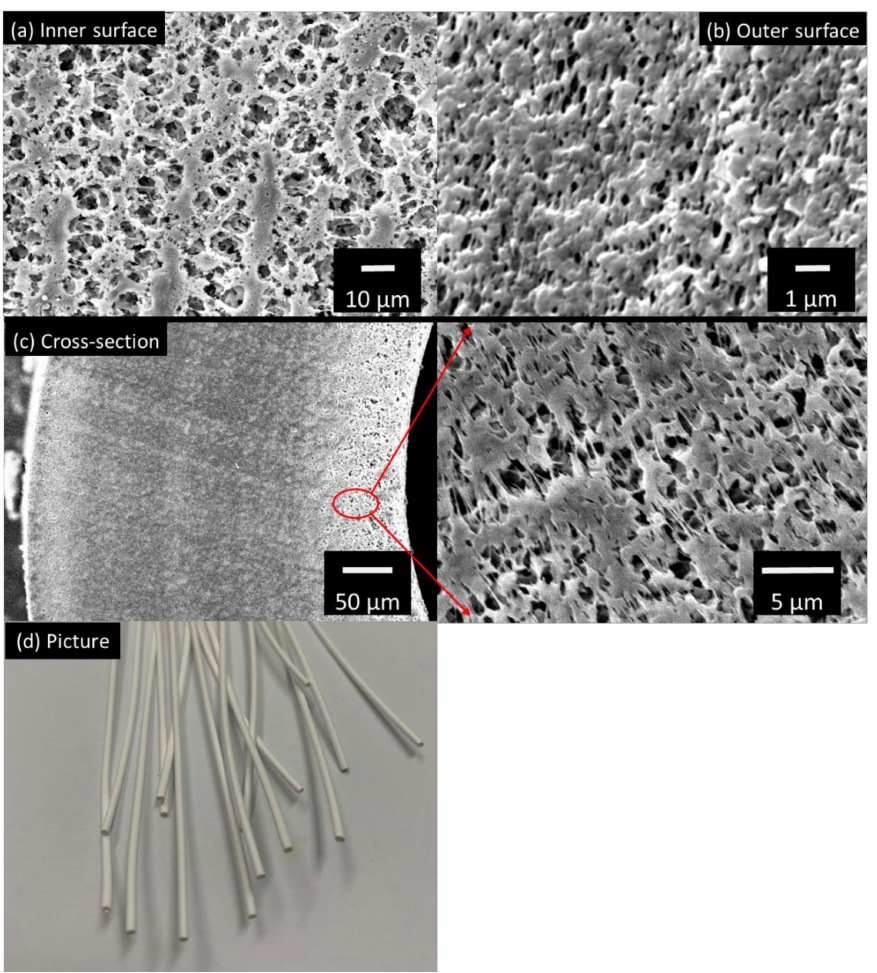
Figure 2. The SEM images of ( a ) the inner surface, ( b ) outer surface, ( c ) cross-section and ( d ) picture of the STOMATE ®